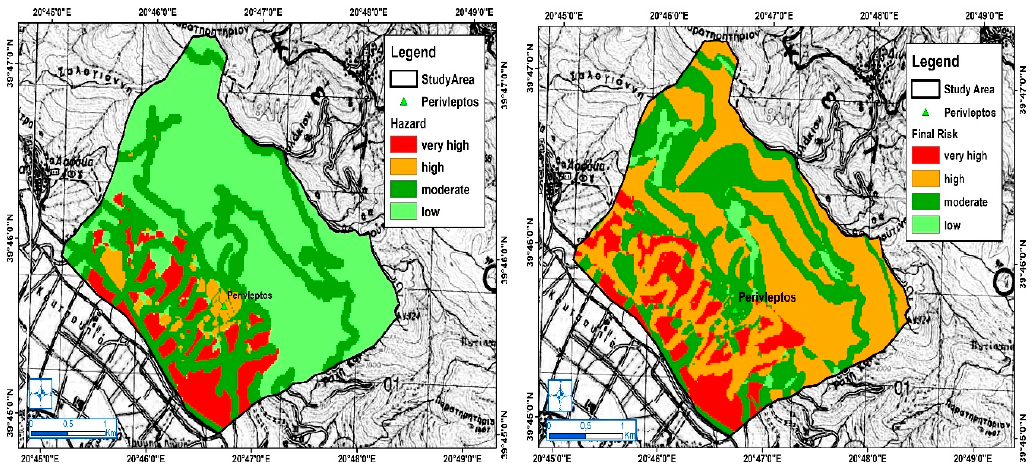
Figure 8. Hazard and risk map of the study area.